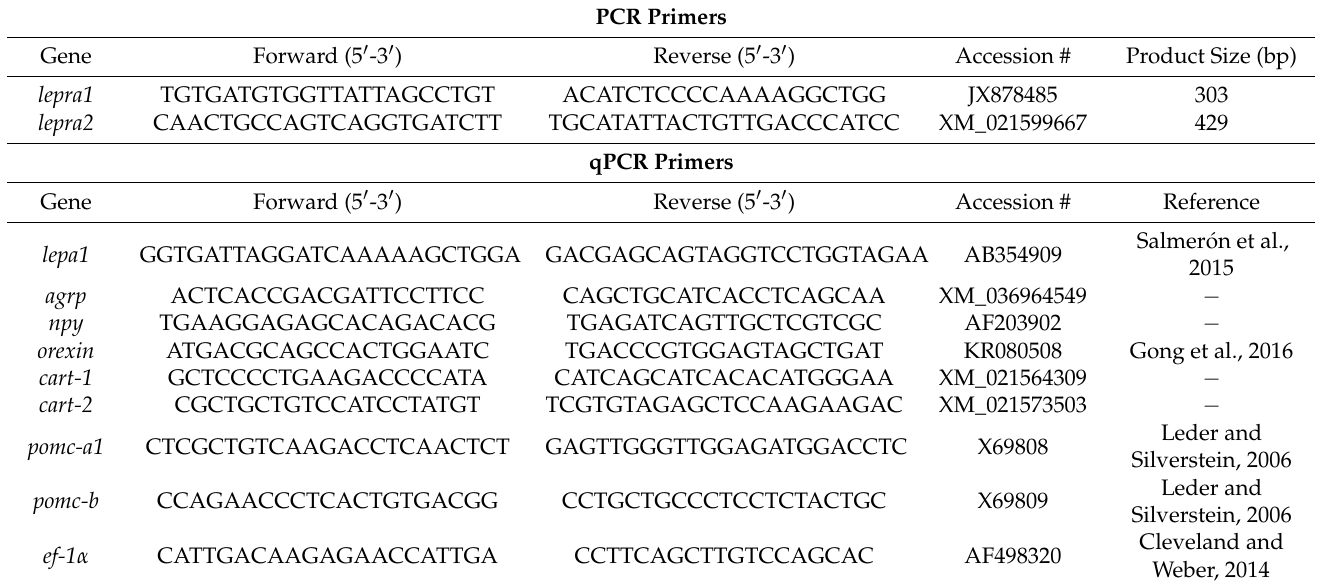
Table 1. List of primer sets used for genotyping polymerase chain reaction (PCR) and quantitative PCR (qPCR) in rainbow